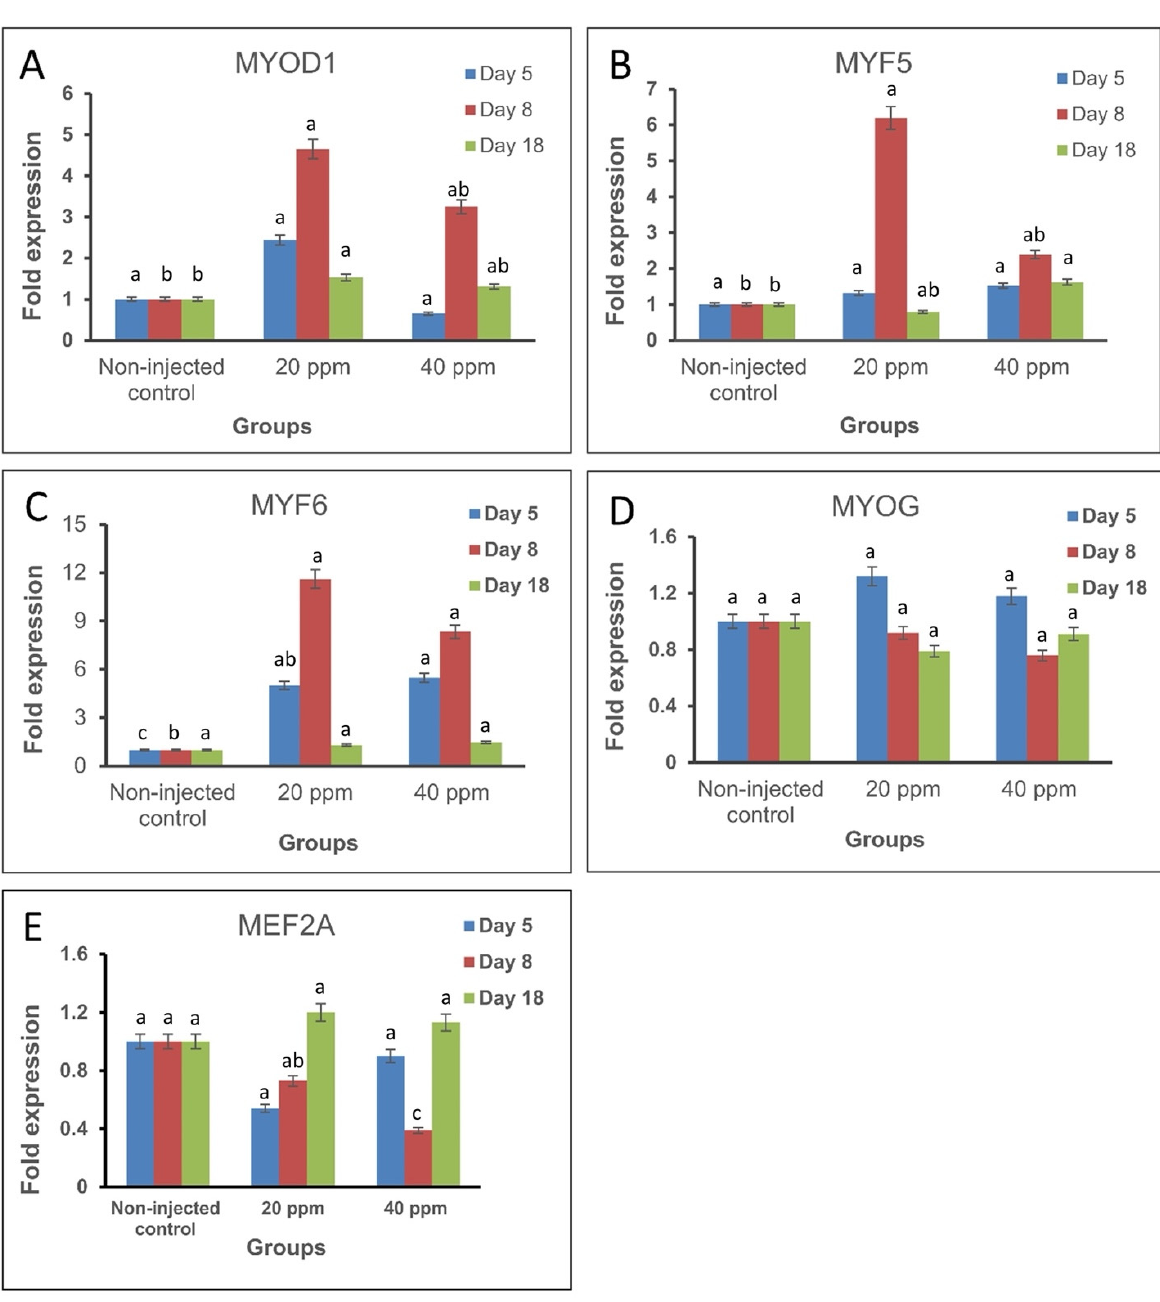
Figure 1. Expression fold change of the studied myogenesis-related genes in breast muscles of chicken embryos ( n = 3, from each group at each time point) at the three sampling timepoints in the treatment groups (treatment I, 20 ppm Nano-Ag; treatment II, 40 ppm Nano-Ag) compared with the non-injected control group. ( A ): MYOD1 , myogenic determination factor 1. ( B ): MYF5 , myogenic factor 5. ( C ): MYF6 , myogenic factor 6. ( D ): MYOG , myogenin. ( E ): MEF2A , myocyte enhancer factor 2A. Error bars indicate standard error. The level of significance is p < 0.05.